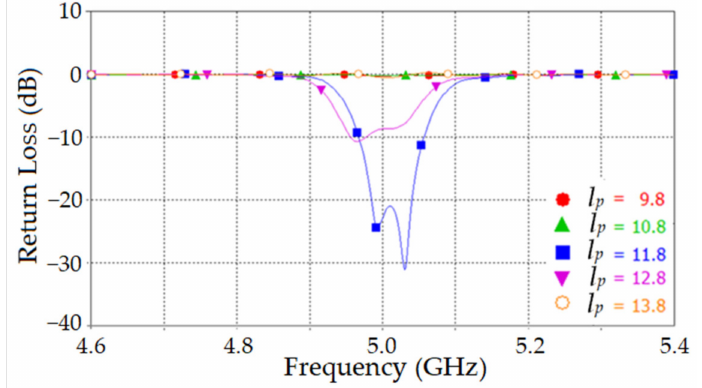
Figure 4. Simulated return loss for different values of ‘ l p ’.